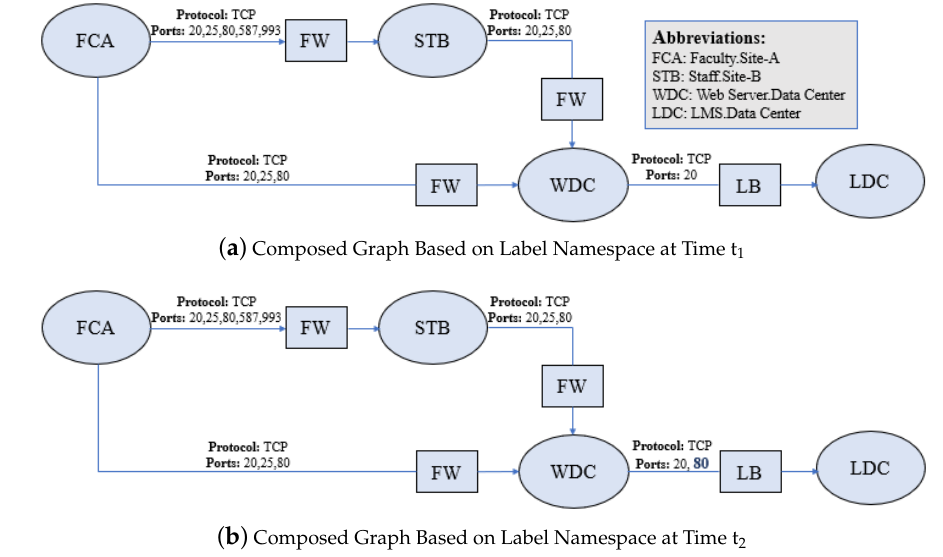
Figure 4. Composed Graph Based on Label Namespace at Different Time